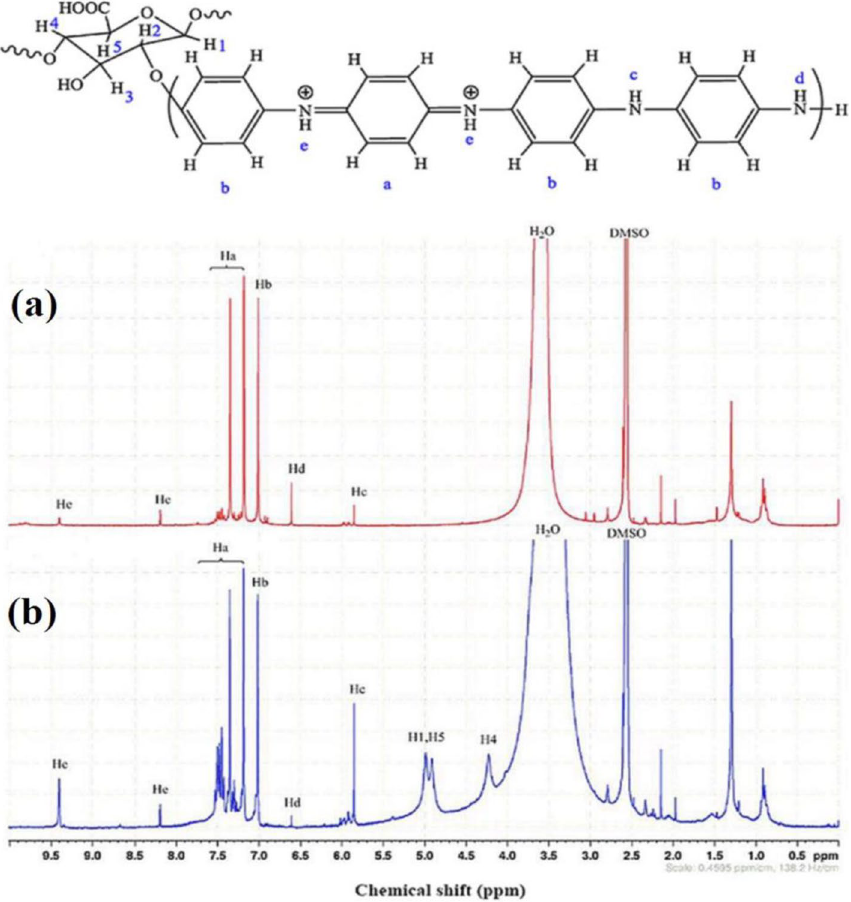
Figure 4. 1 H NMR spectra of PANi ( a ) and HPEc-g-PANi ( b ) in DMSO-d 6